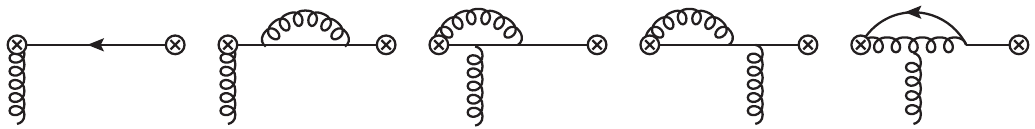
Figure 1: Feynman diagrams contributing to the jet function at one-loop order in light-cone gauge. Note that the third diagram evaluates to zero since it it